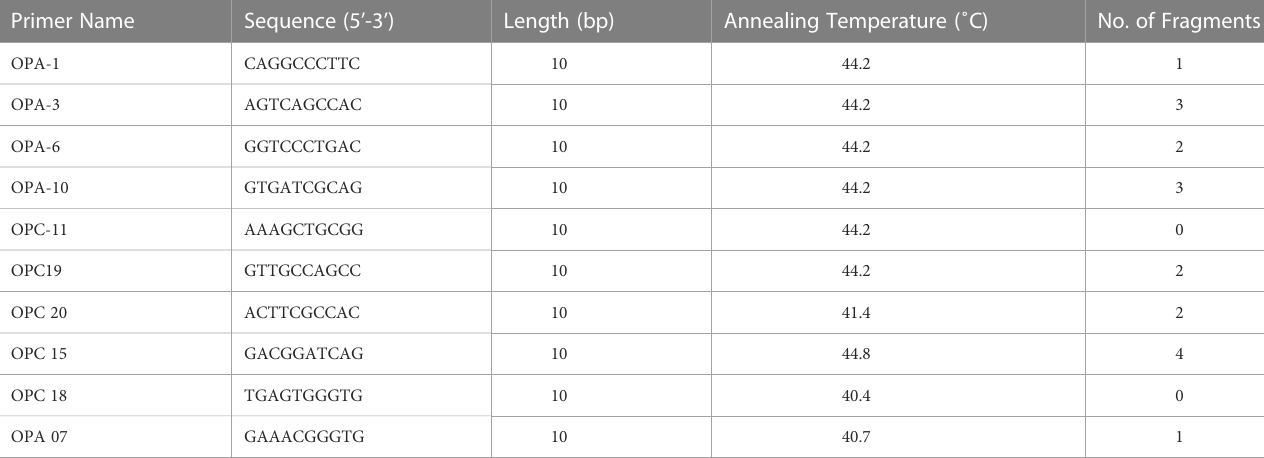
TABLE 4 List of RAPD primers used to con fi rm the genetic fi delity of D. transparens . Primer Name